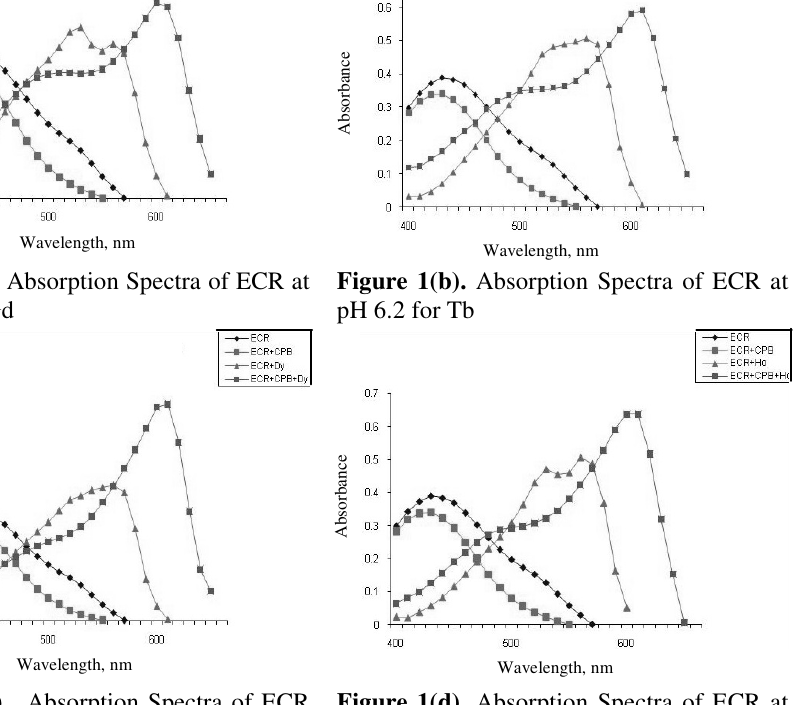
Figure 1(d). Absorption Spectra of ECR at pH 6.0 for